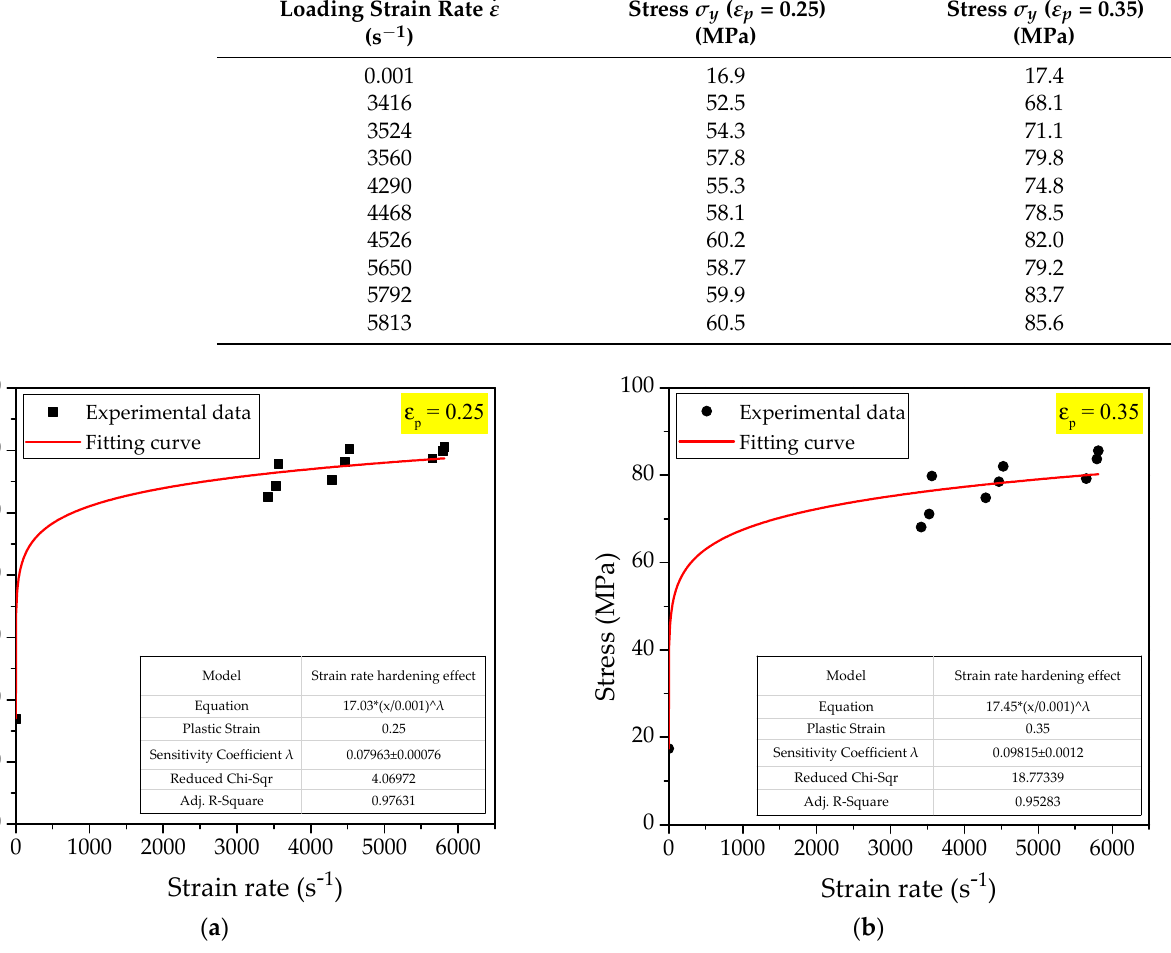
Figure 17. The fitting curve of strain rate hardening effect: ( a ) ε p = 0.25; ( b ) ε p = 0.35.